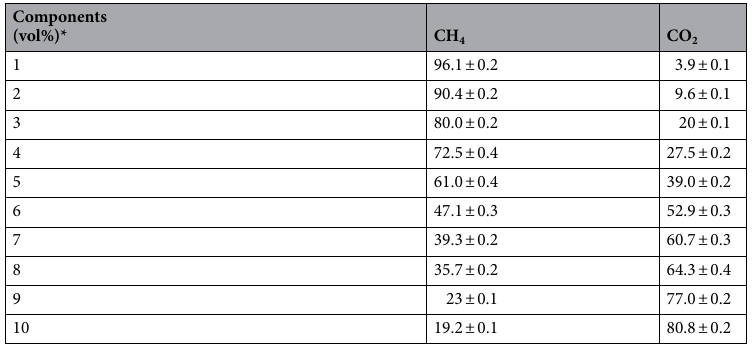
Table 1. Composition of the binary gaseous mixtures used in this study. *The absolute measurement uncertainties (95% confidence interval) are given after the measured value.